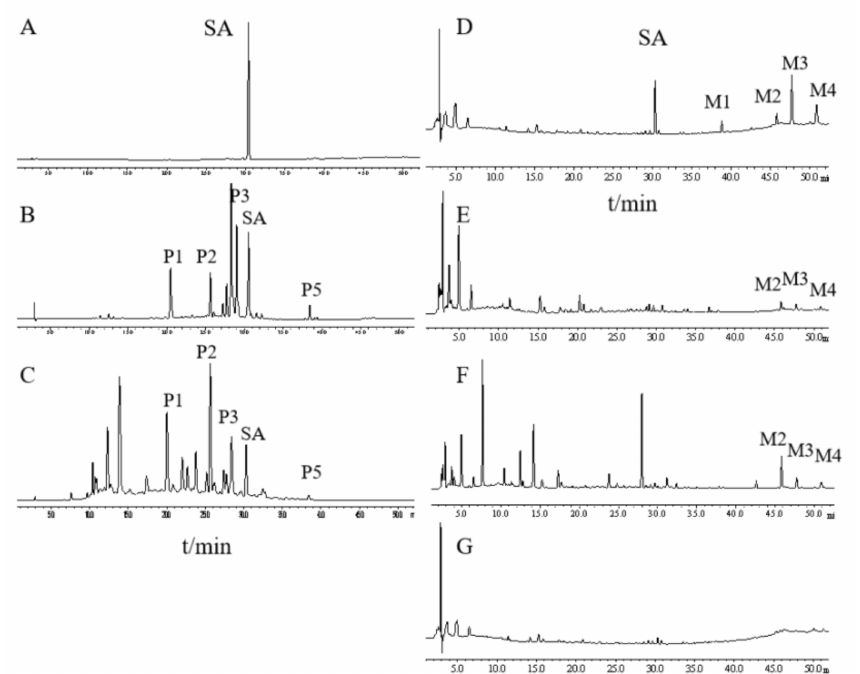
Figure 1. In vitro biotransformation was performed on the products in the rat fecal flora solution for 8 h, and metabolites produced were analyzed using HPLC. HPLC chromatogram of ( A ) sennoside A (SA). ( B ) senna anthraquinones (SAQ). ( C ) rhubarb anthraquinones (RAQ). ( D ) metabolites of SA. ( E ) metabolites of SAQ. ( F ) metabolites of RAQ. ( G ) the rat fecal flora